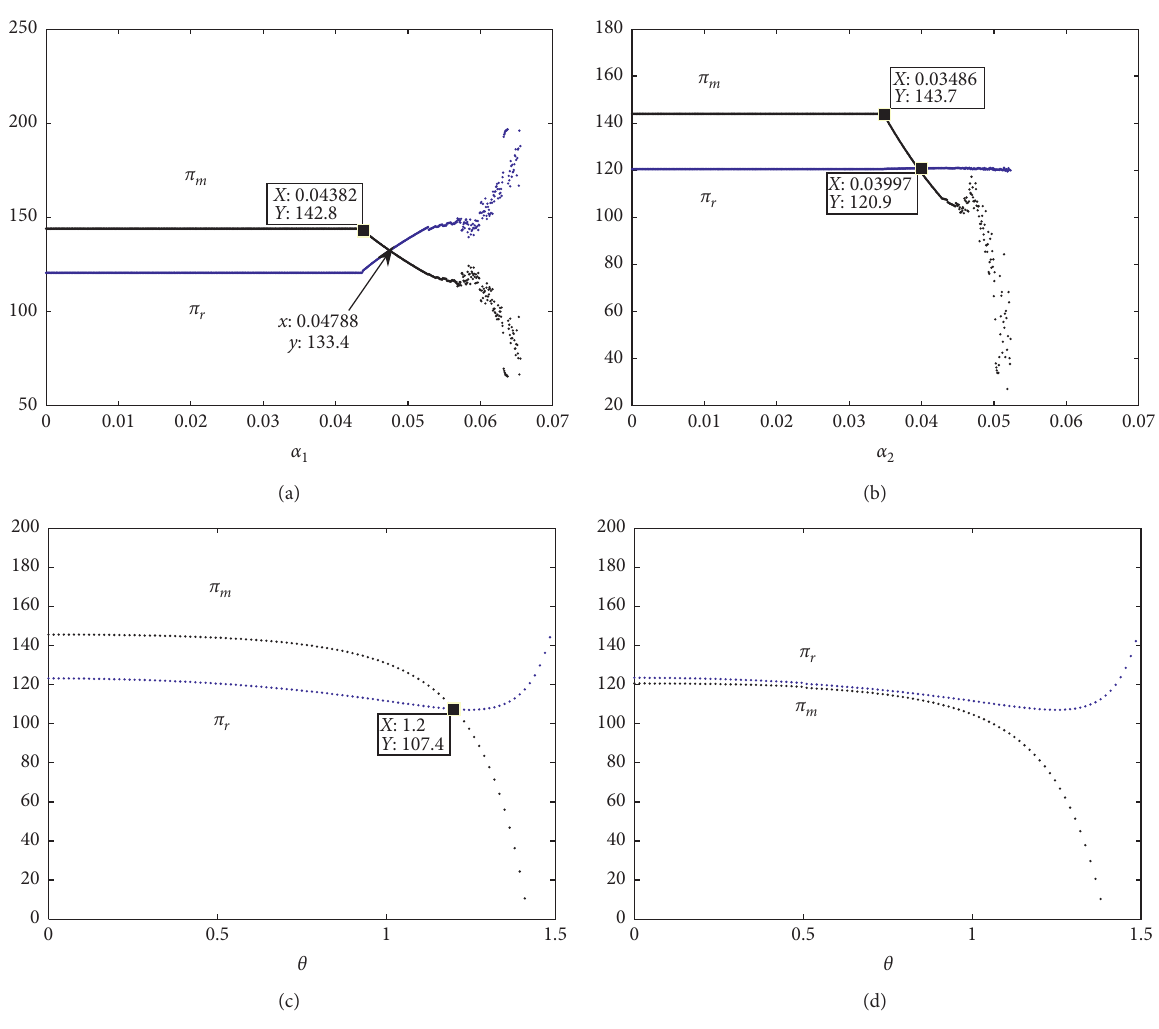
Figure 5: The influence of parameters on the